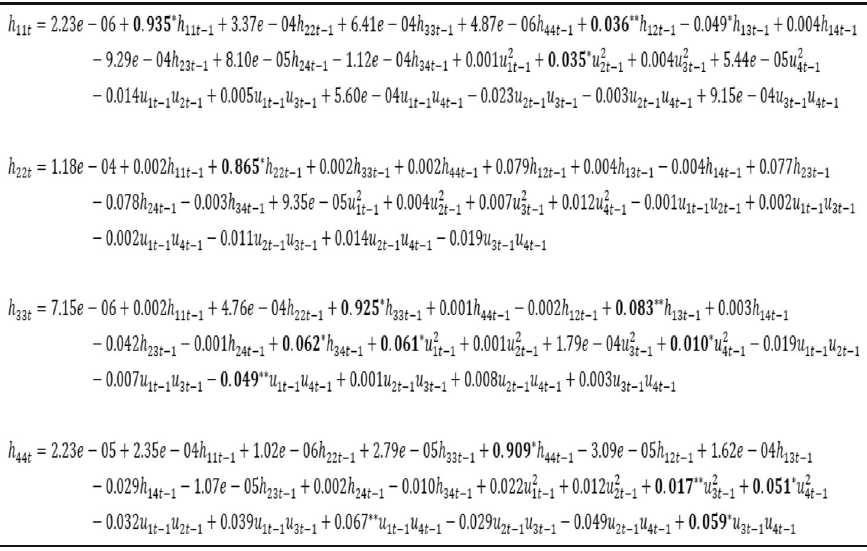
respectively. Significant parameters are also in